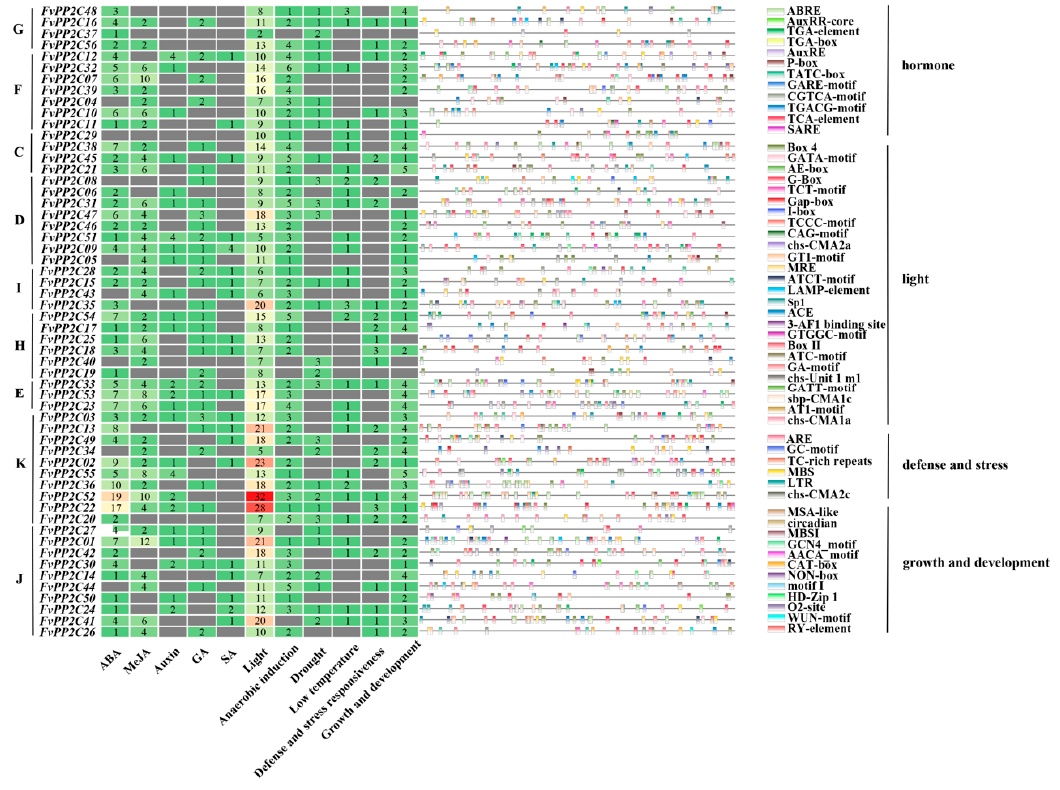
Figure 7. Cis -regulatory element analysis of the FvPP2C genes. Note: Different letters on the left indicate different subgroups (C–K). Different colors on the right represent different elements. All elements can be divided into four categories, namely, hormone response elements, light response elements, defense and stress response elements, and growth and development related elements. The total number of abscisic acid (ABA), methyl jasmonate (MeJA), auxin, gibberellin (GA) and salicylic acid (SA) response elements, light response elements, anaerobic induction elements, drought re- sponse elements, low temperature response elements, defense and stress response elements, and growth and development response elements are shown in the heat map.